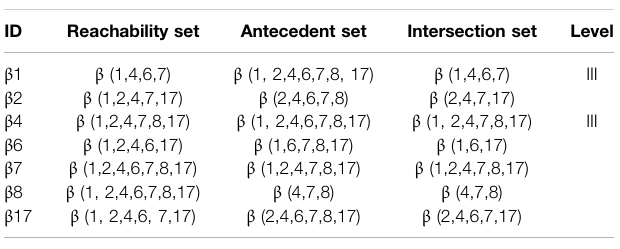
TABLE 11 | Partition level V.